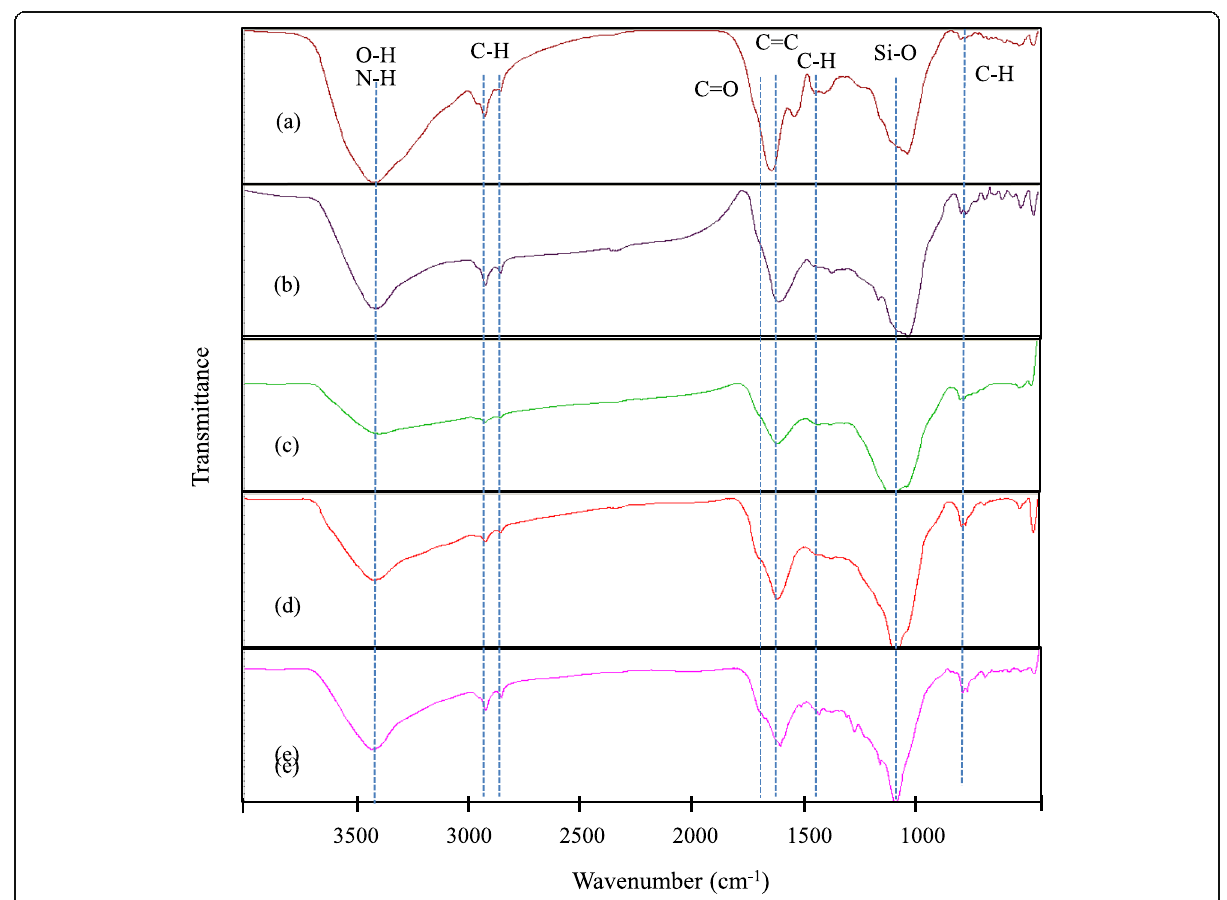
Fig. 2 FTIR spectrums of ( a ) SBC, ( b ) 33%ZnCl 2 -SBC, ( c ) 50%ZnCl 2 -SBC, ( d ) 60%ZnCl 2 -SBC and ( e ) 67%ZnCl 2